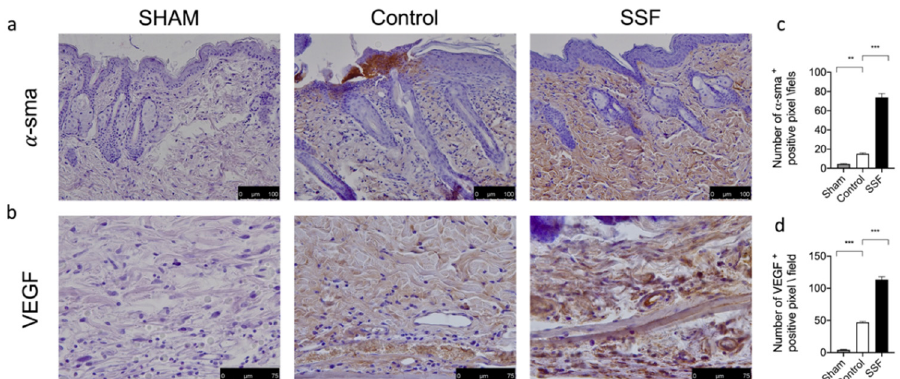
Figure 4. Effect of SSF on α -sma and vascular-endothelial growth factor (VEGF) expression. Im- munohistochemical analysis of ( a , c ) α -sma and, ( b , d) VEGF on wound bed tissue. Data are presented as means ± SEM images of 10 mice for each group. ** p < 0.01; *** p < 0.001.